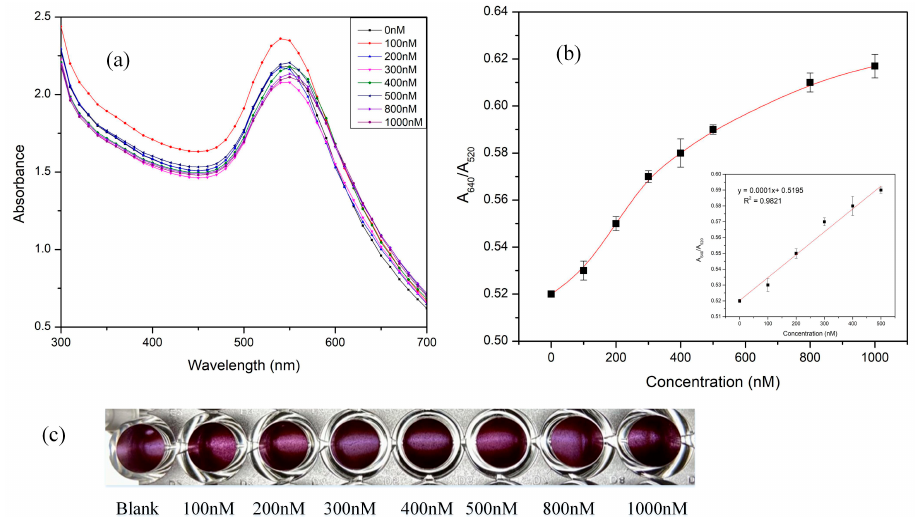
Figure 8. ( a ) Shown is the spectral data of preconditioned gentamicin-spiked milk samples on interaction with gentamicin aptamer (200 µL AuNP + 1 µM GA + x nM (20 µL) gentamicin spiked milk + 280 mM NaCl). ( b ) A640/A520 ratios of the spectral data and inset shows the linear range of the data ( c ) experiments performed on processed milk samples using a 96-well